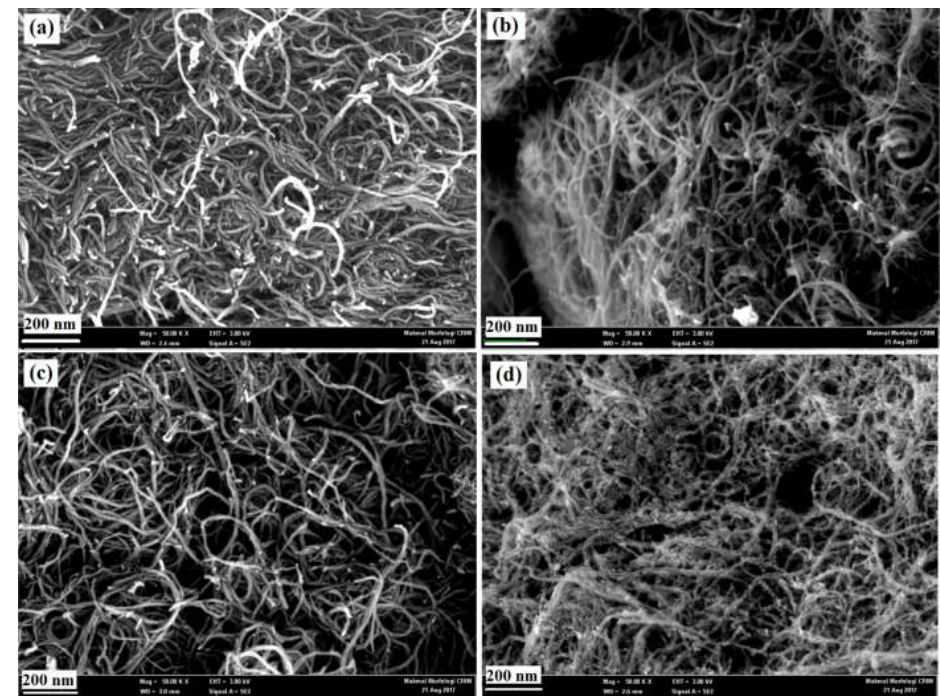
Figure 1. FESEM images (×50 k; WD = 3 mm; EHT = 3kV) of various electrocatalysts: ( a ) MWCNT-Pt; ( b ) MWCNT-PBI-Pt; ( c ) MWCNT-Nafion-Pt; and ( d ) MWCNT-PTFE-Pt.